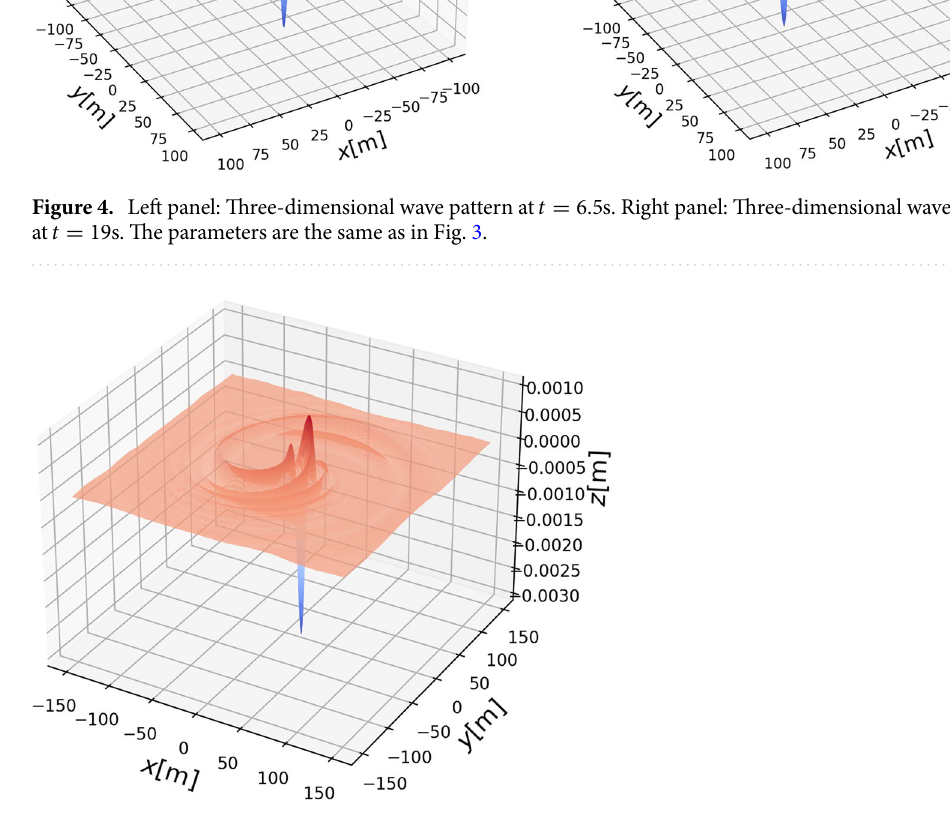
Figure 5. A three-dimensional plot of the wave response at t emerges as the vehicle continues to go in a circle. The parameters are the same as in Fig.